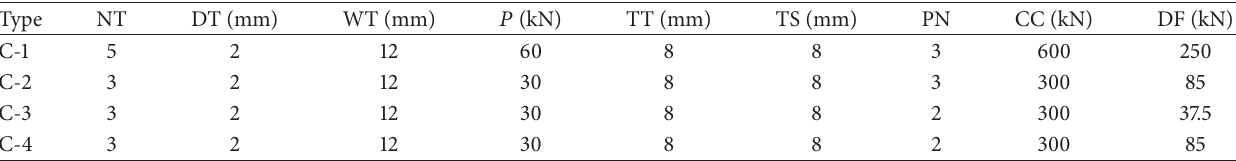
Table 3: Size and bearing capacity of the joints.